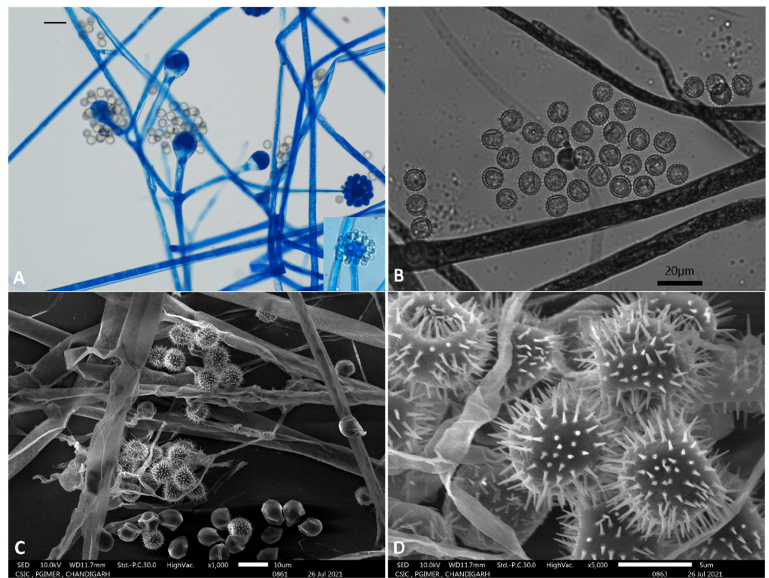
Figure 5. ( A ) Bright field microscopy showing mold with erect sporangiophore ending in a swollen vesicle, with 1-spored sporangiola(inset) and lateral branches with vesicles and sporangiola with a whorl of 3–5 branches suggestive of Cunninghamella (Scale bar 20 µm) ( B ) Brightfield microscopy showing echinulate spores (Scale bar 20 µm). ( C ) Scanning electron microscopy of Cunninghamella arunalokei showing rough sporangiola, some of which are collapsed (Scale bar 10 µm). ( D ) Scanning electron microscopy of Cunninghamella arunalokei showing echinulate spores (Scale bar 5 µm).